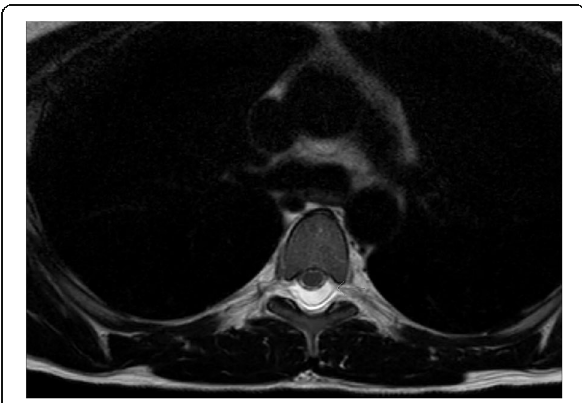
Fig. 2 MRI (T2-weighted), TH5/TH6, horisontal: CSF surrounding nerve roots and dislocating the dural